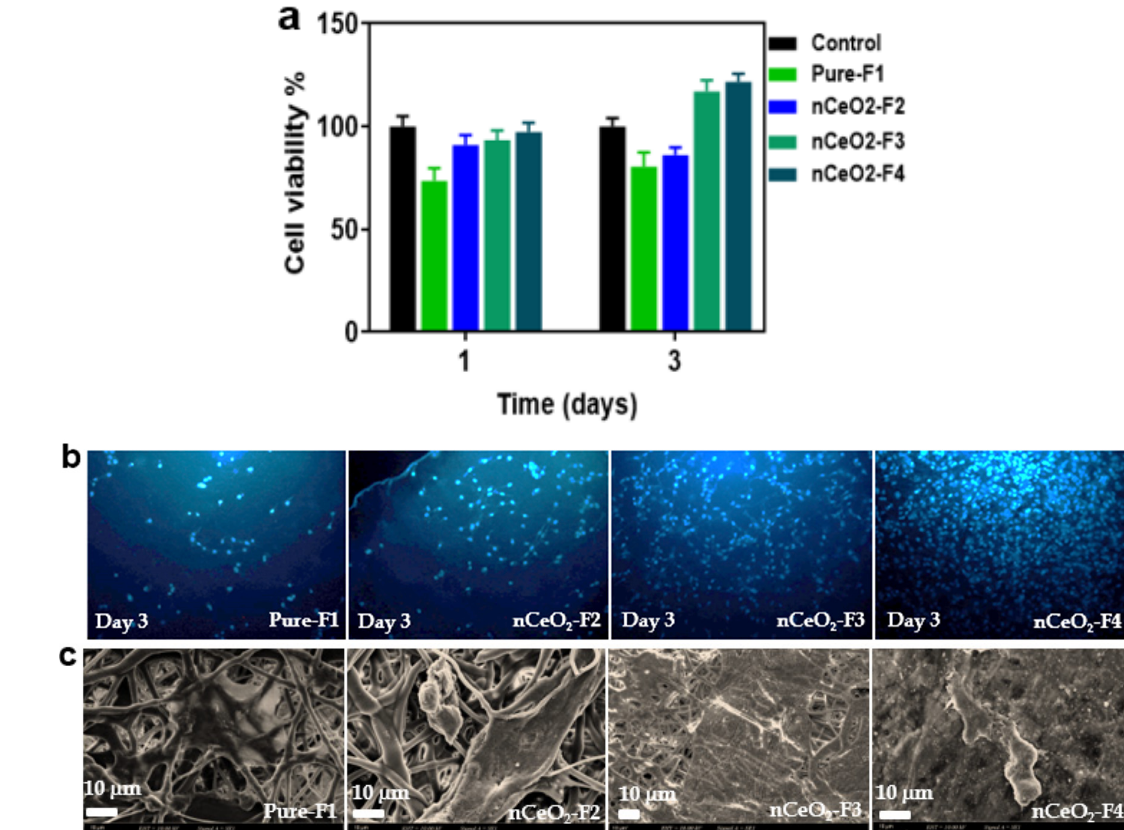
Figure 7. Cell viability using MTT assay ( a ); fluorescence images showing the proliferation of mouse fibroblast cell line (3T3) on the nanofibrous mats, using DPAI staining after 3 days ( b ); and SEM micrographs of cells proliferation and adhesion on the pure and nCeO 2 ; loaded nanofibrous mats ( c ).